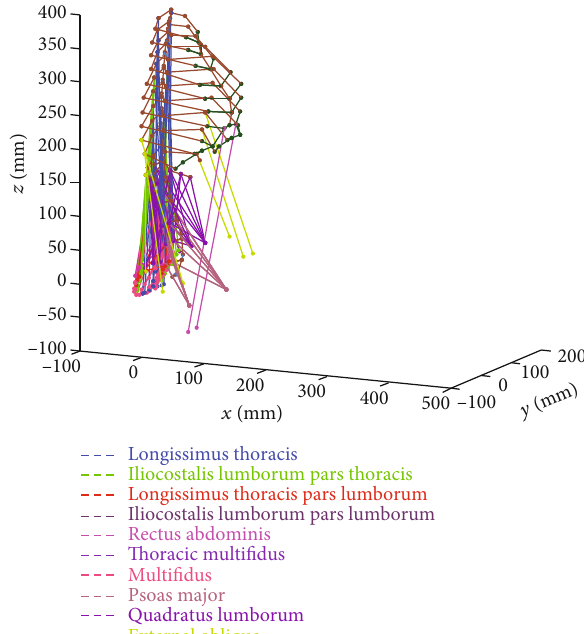
Figure 1: Trunk model comprising the spine, the thoracic cage, and 174